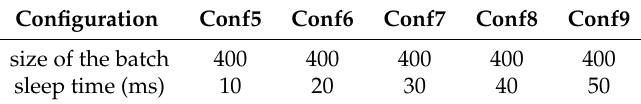
Table 2. Different configurations of KSM.